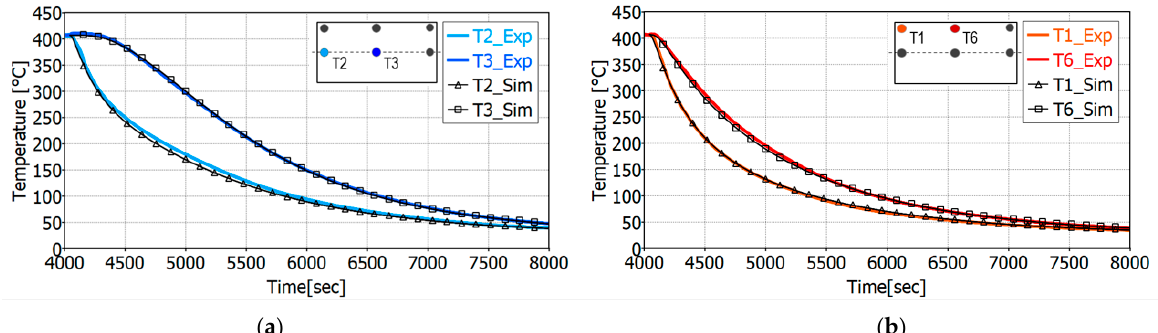
Figure 6. Temperature along the axial direction ( a ) in the center of the monolith and ( b ) close to the periphery. Test 6-Tinit = 400 °C, Inclination = 0°.